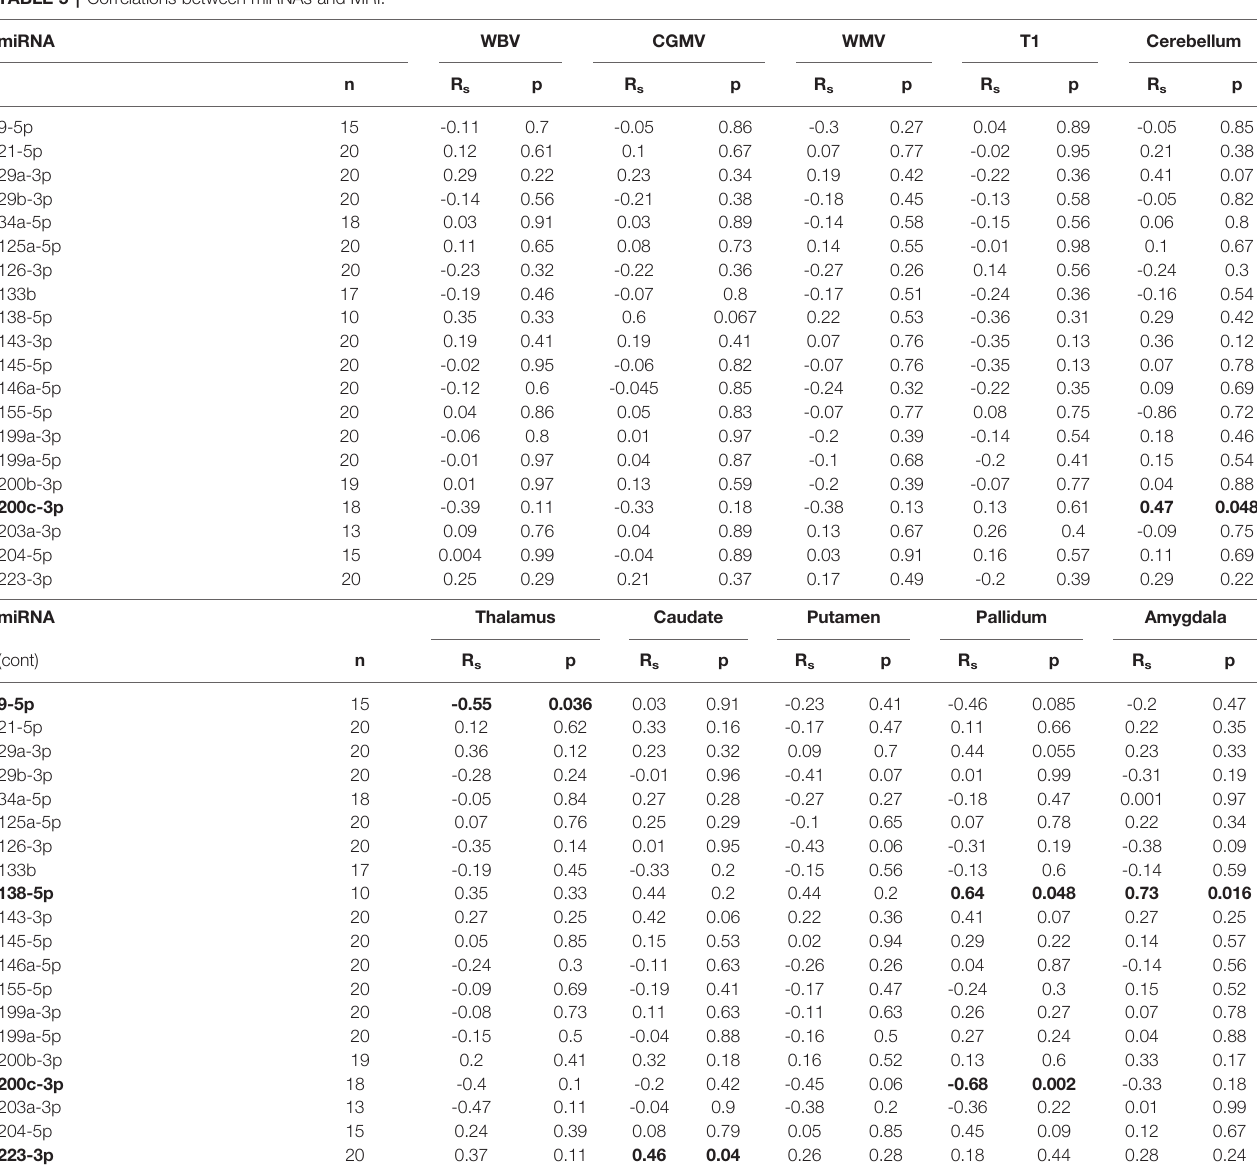
TABLE 5 | Correlations between miRNAs and MRI. miRNA